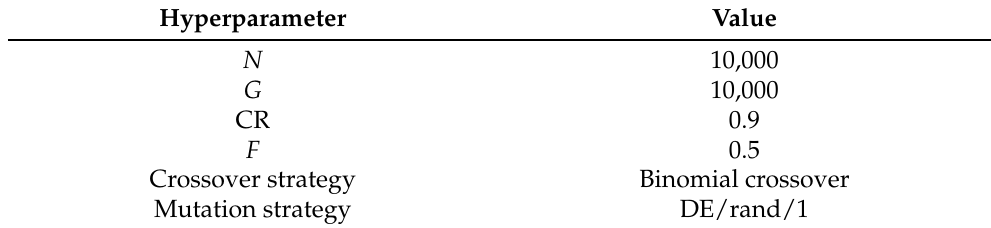
Table 4. Set values for DE.